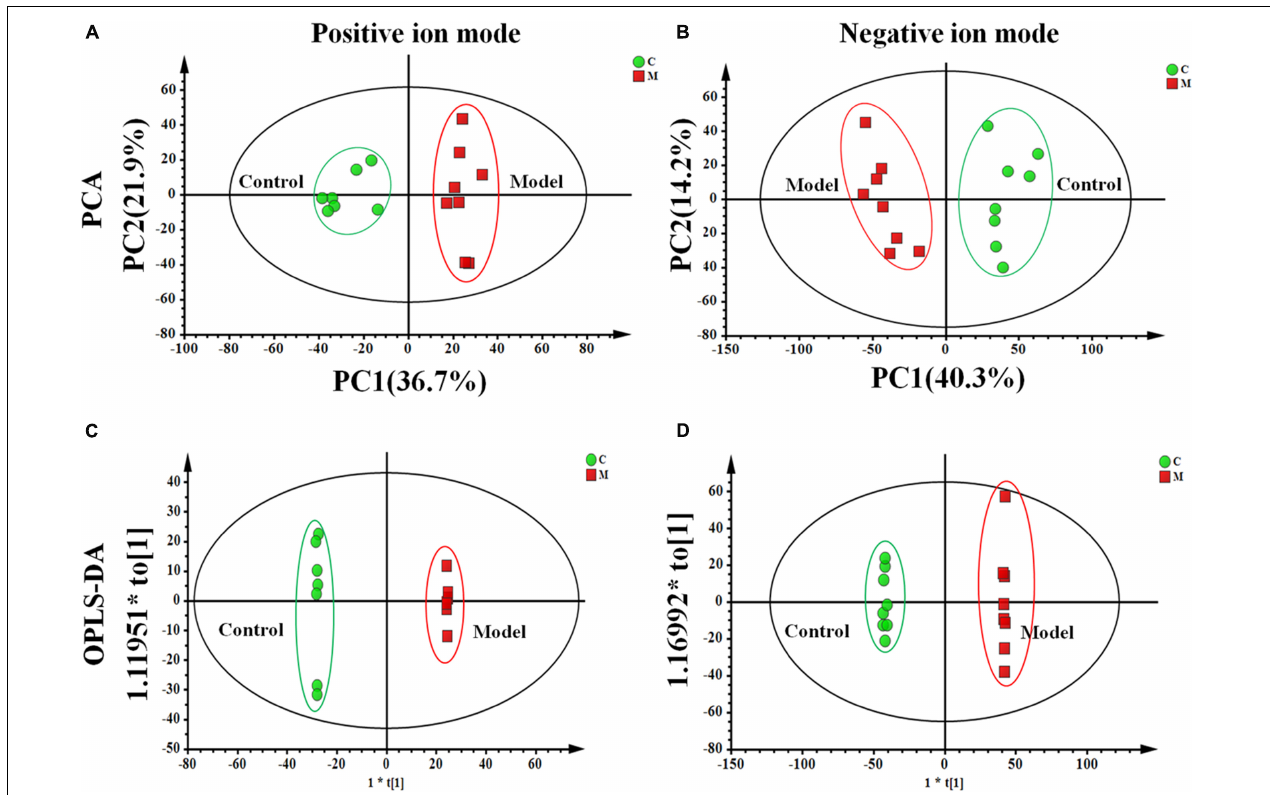
FIGURE 4 | The metabolic profile of cecal contents in the ISO-induced AMI differs from that of in the control group. The PCA score plot of cecal contents between the control and model groups in (A) positive ion mode [ R 2 X = 0.714, Q 2 = 0.534] and (B) negative ion mode [ R 2 X = 0.808, Q 2 = 0.514]. The OPLS-DA score plots of cecal contents from the control and model groups in (C) positive ion mode [ R 2 X = 0.803, R 2 Y = 0.998, Q 2 = 0.923] and (D) negative ion mode [ R 2 X = 0.806, R 2 Y = 0.999, Q 2 =